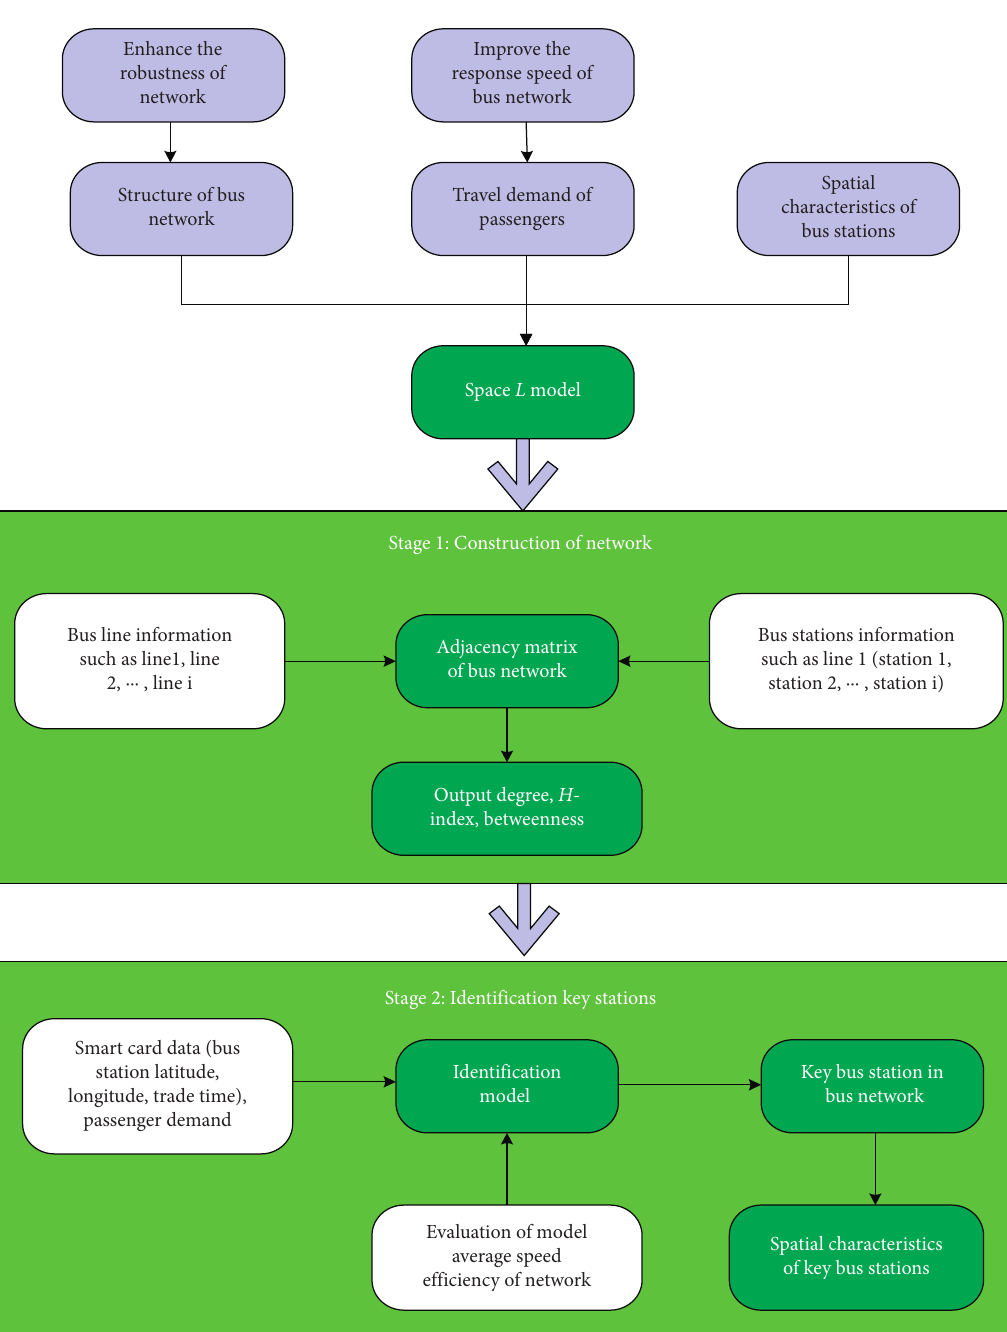
Figure 2: The solution